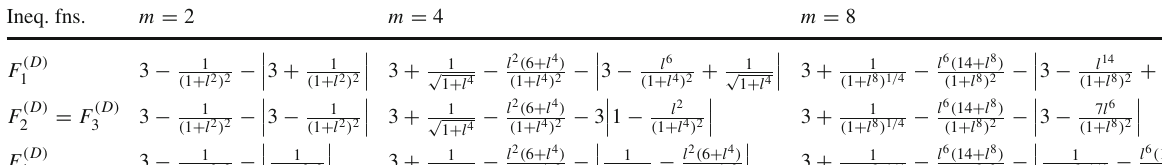
Table 6 Inequality functions of DEC for decaying warp factor, at y = 0, b 0 = 1, m = 2 , 4 and 8 Ineq. fns.